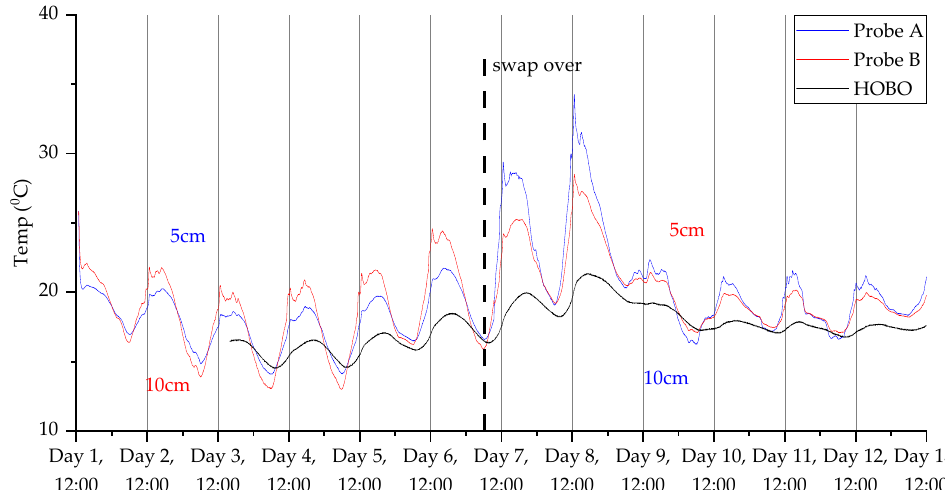
Figure 15. Temperature measurements for the second deployment in Wellesbourne campus woodland. Data collection commenced on 12 July 2022 at 12:45 (24 h time).